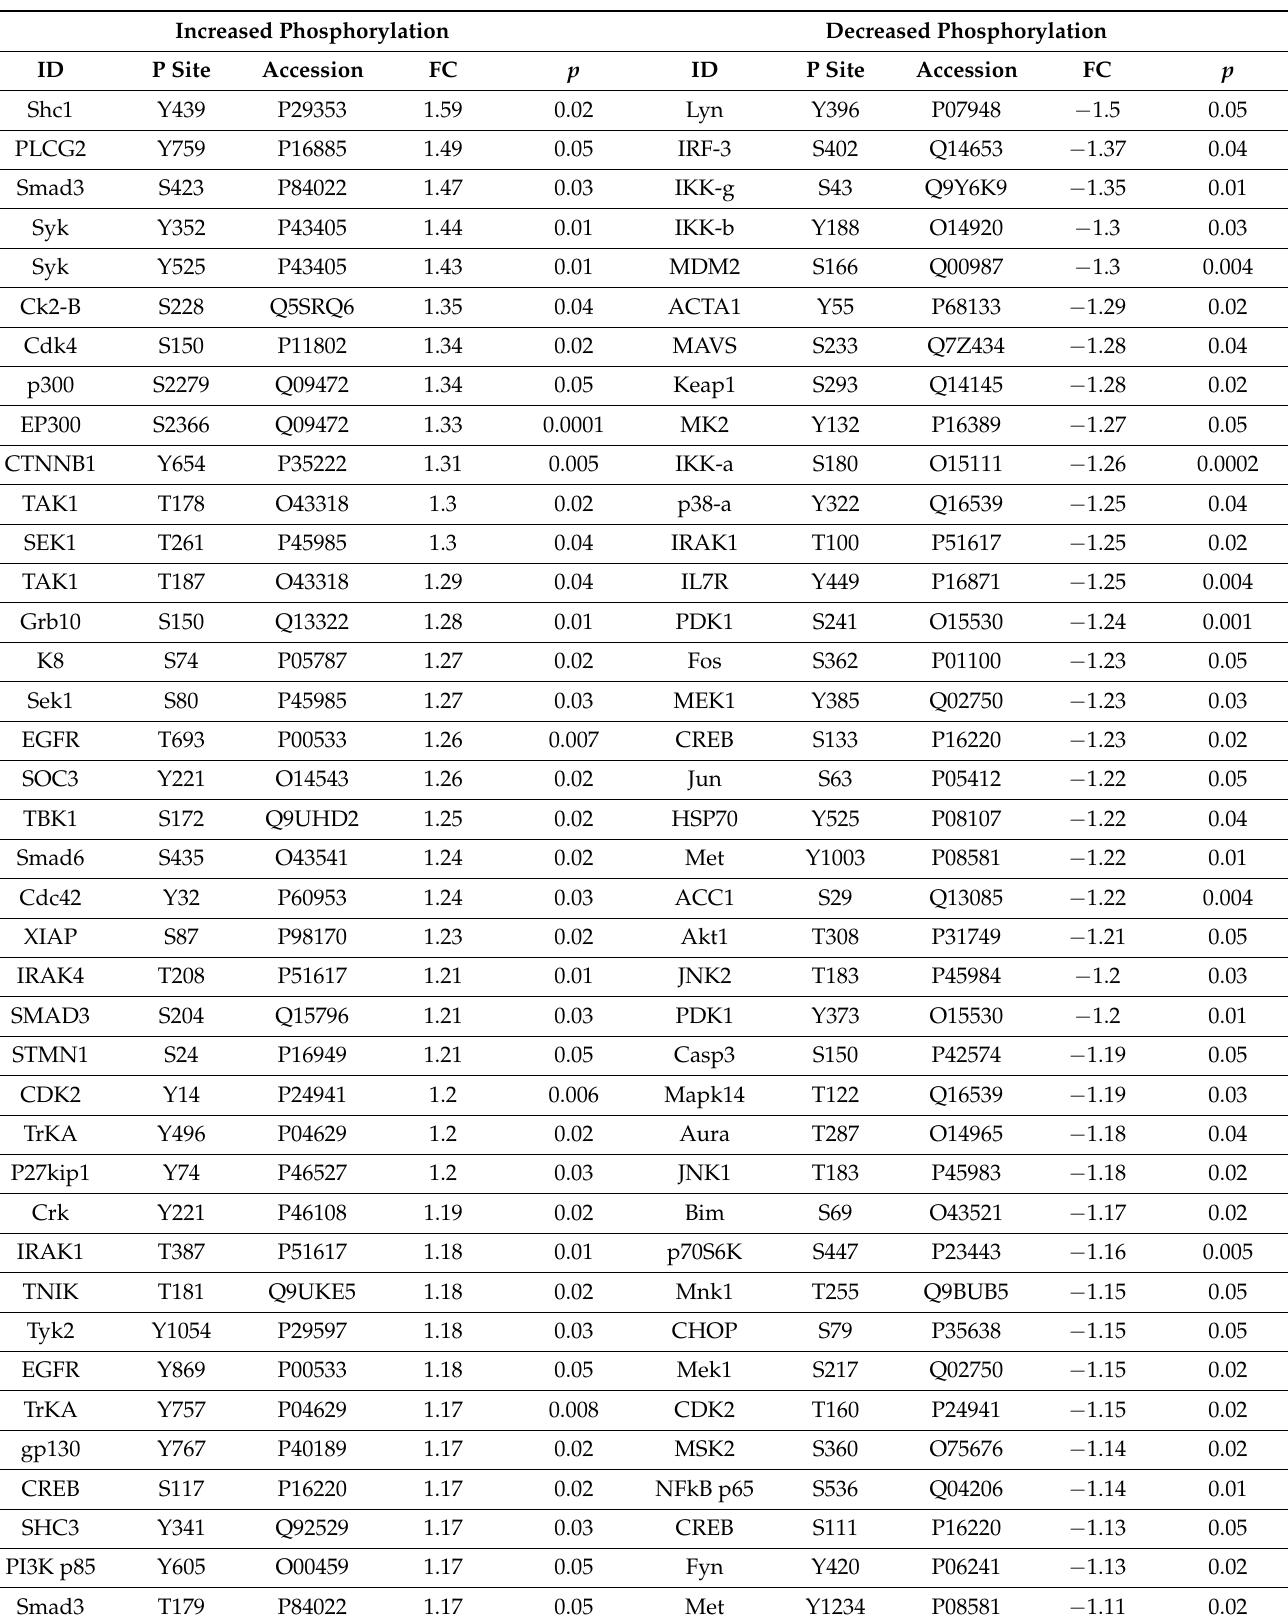
Table 2. Differentially Phosphorylated Peptides in Muscle is Response to